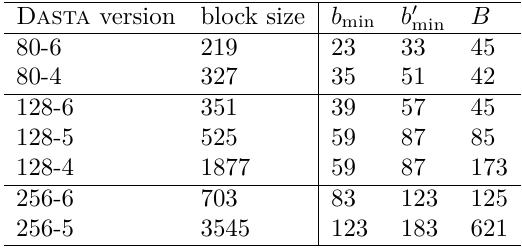
Table 6: Linear branch numbers of Dasta . b min corresponds to Eq. 6, while b 0 corresponds to the previous known bound in Eq.